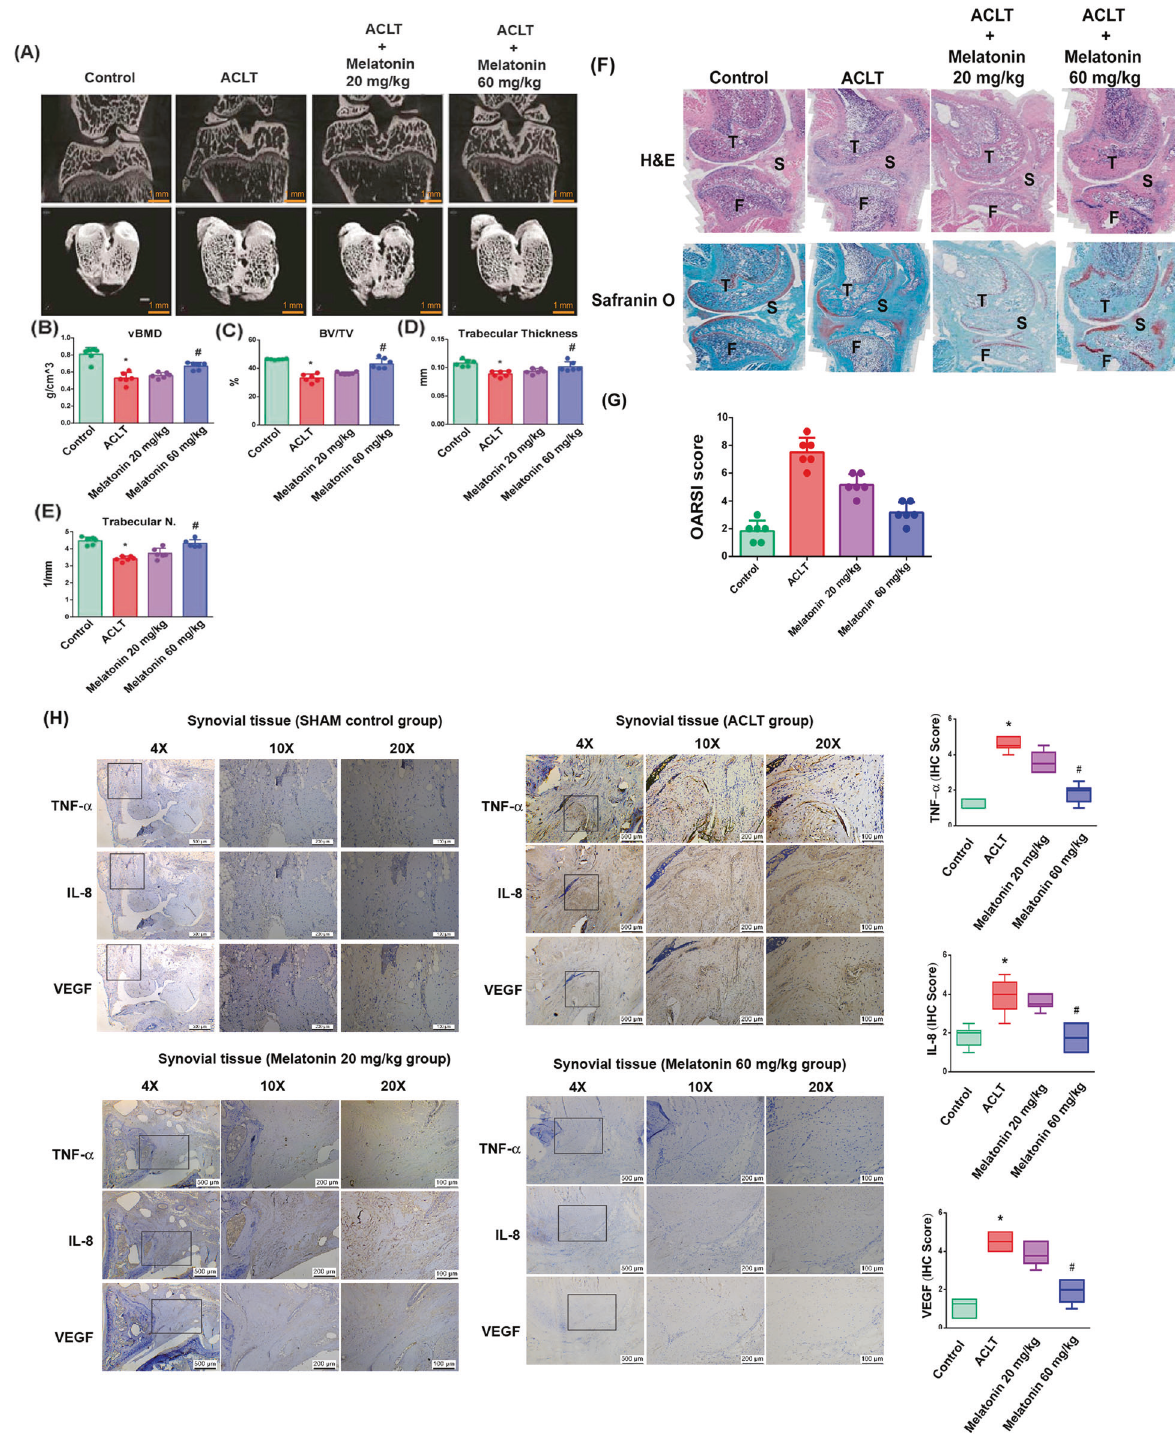
Fig. 5 Melatonin ameliorated synovium in fl ammation and cartilage degradation in the ACLT OA animal model. A Photomicrographs of a control knee, ACLT knee, and melatonin-treated knee, with coronal and transverse views from micro-CT imaging ( n = 6). B – E Graphic illustrations of vBMD, bone volume, trabecular bone thickness, and trabecular numbers in the different study groups. F , G Histological sections from knees ( n = 6) stained with H&E and Safranin-O and associated OARSI scores (S synovium, T tibial, F femoral). H IHC staining images from each group showing low- to high-power fi elds of view for synovial tissue from the same position of joint and quanti fi cation of IHC scores. * p < 0.05 versus the control group; # p < 0.05 versus the ACLT-only group.